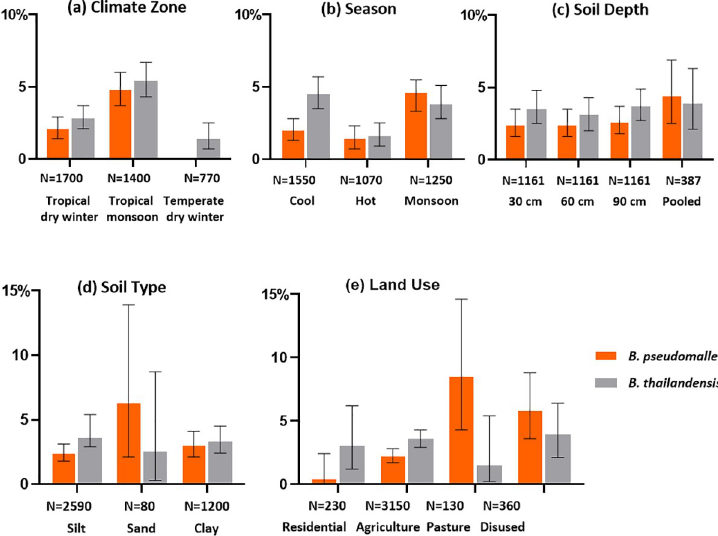
Fig 2. Bar-plot showing percentage of sample positive for B . pseudomallei and B . thailandensis in different categories of (a) Climate zone (b) Season (c) Soil depth (d) Soil type and (e) Land use. The numbers below each category represent the total number of samples collected in the corresponding